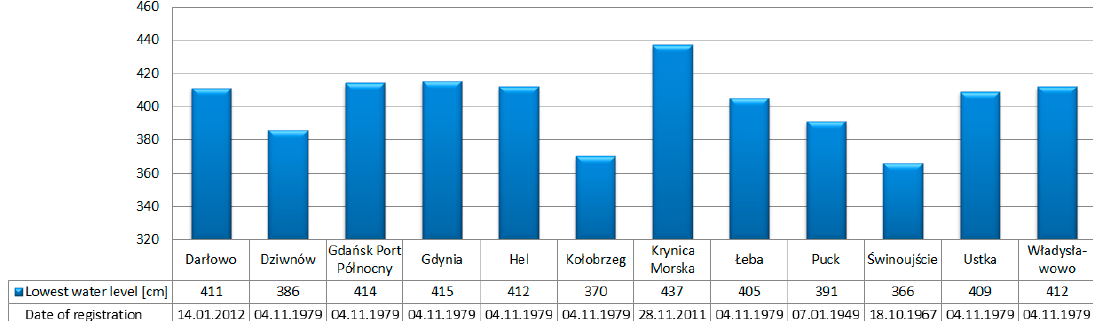
Figure 6. Absolutely lowest water levels ever recorded at Polish gauging stations in the years 1945–2015.